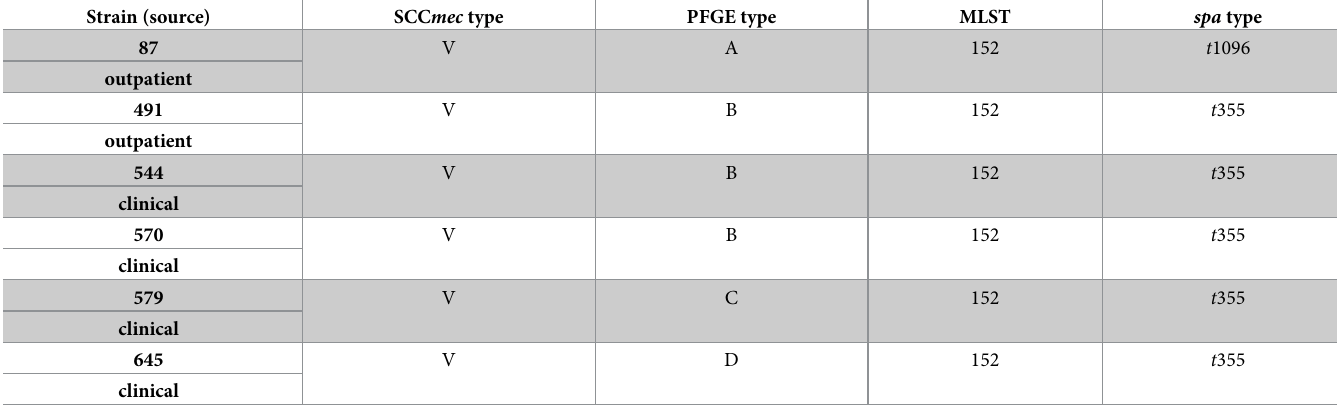
Table 2. Molecular characterisation of PVL-positive MRSA